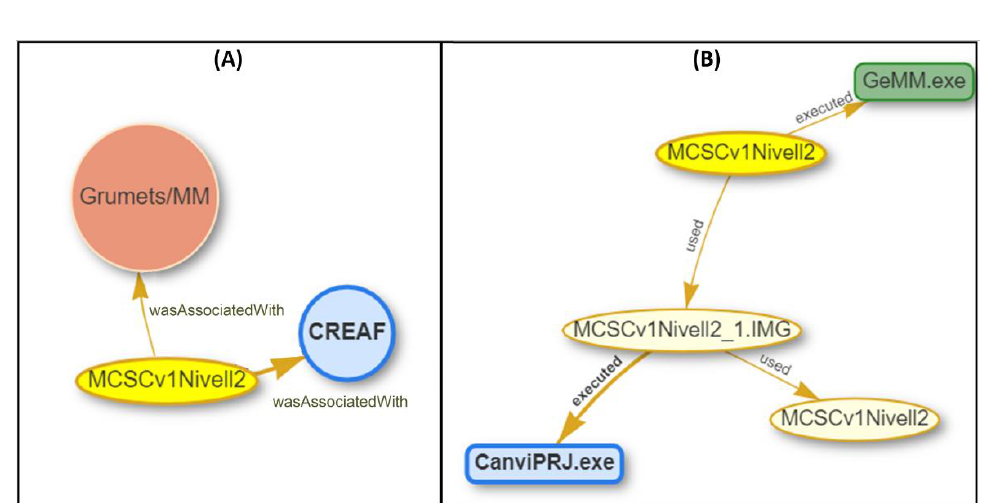
Figure 11. ( A ) agents involved in the generation of the MCSC version 1. ( B ) processing tools and sources involved in the MCSC version 2.